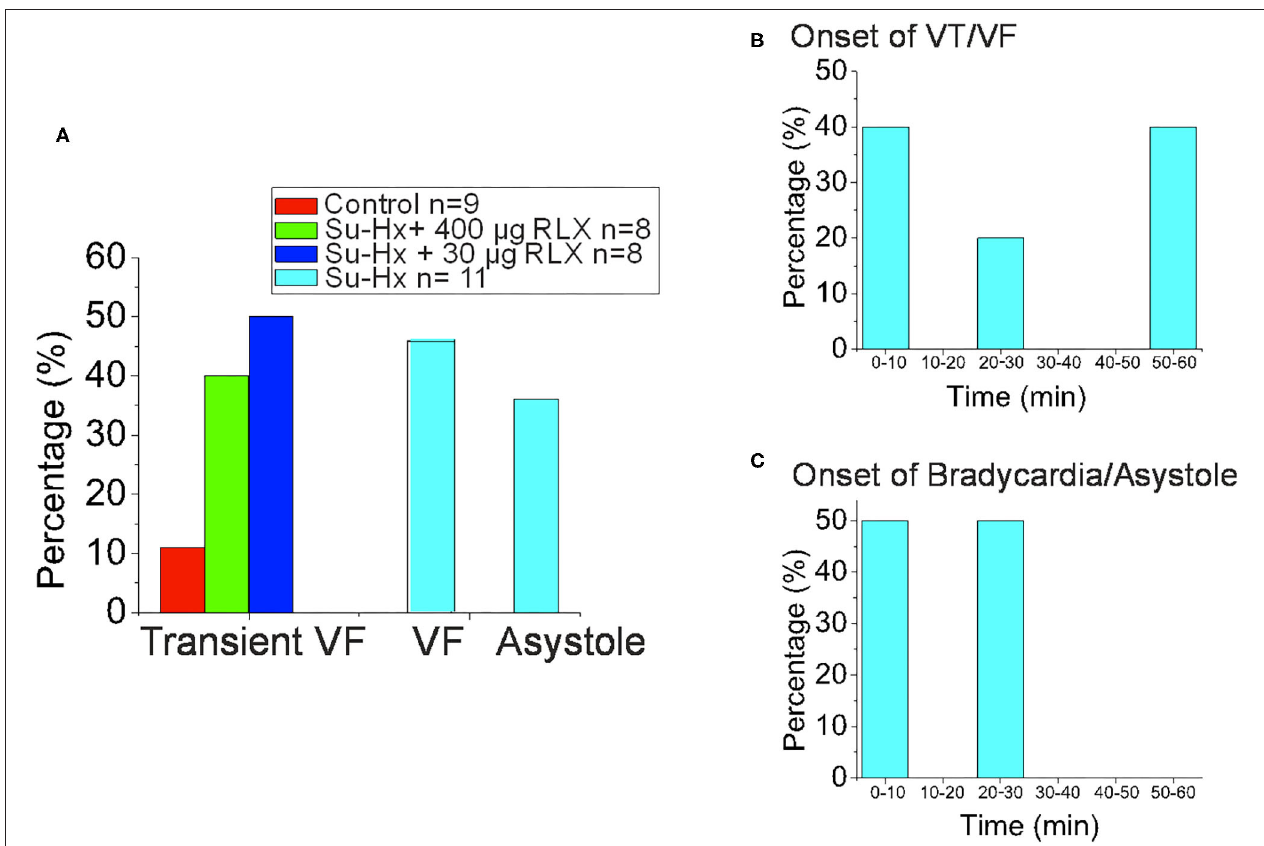
FIGURE 6 | Summary of Experimental Arrhythmia Phenotypes. (A) Histogram of the onset of VT/VF. (B) Histogram of the Percentage of Hearts that exhibited Transient VF lasting > 10s, sustained VF or sustained Asystole. (C) Histogram of the onset of